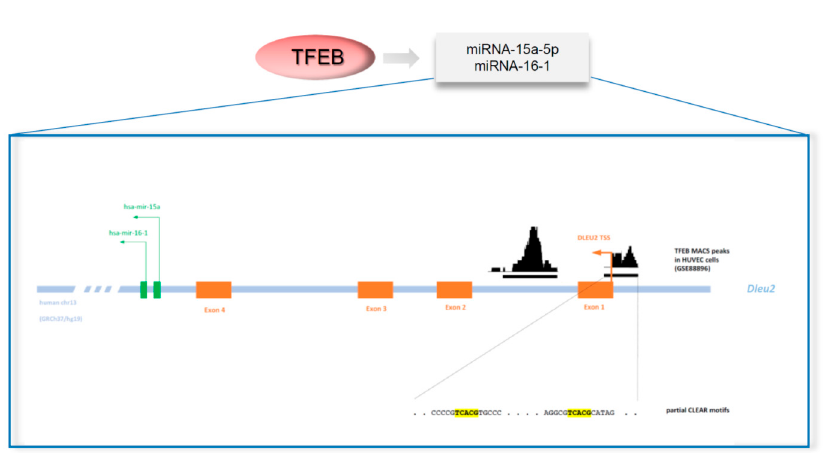
Figure 8. Example of TFEB binding sites, directly regulating the transcription of miRNAs. The non-coding human DLEU2 gene locus is schematically represented (not in scale). The DLEU2 gene hosts inside one of its introns the hairpin precursors hsa-mir-16-1 and hsa-mir-15a. In a model of human endothelial cells, data from GSE88896 [12] highlighted the presence of two TFEB MACS peaks in the close proximity of the DLEU2 promoter region and the direct regulation of mature miR-15a-5p and miR-16-5p by TFEB. Inspection of the TFEB peaks sequences revealed the presence of multiple partial CLEAR binding sites.